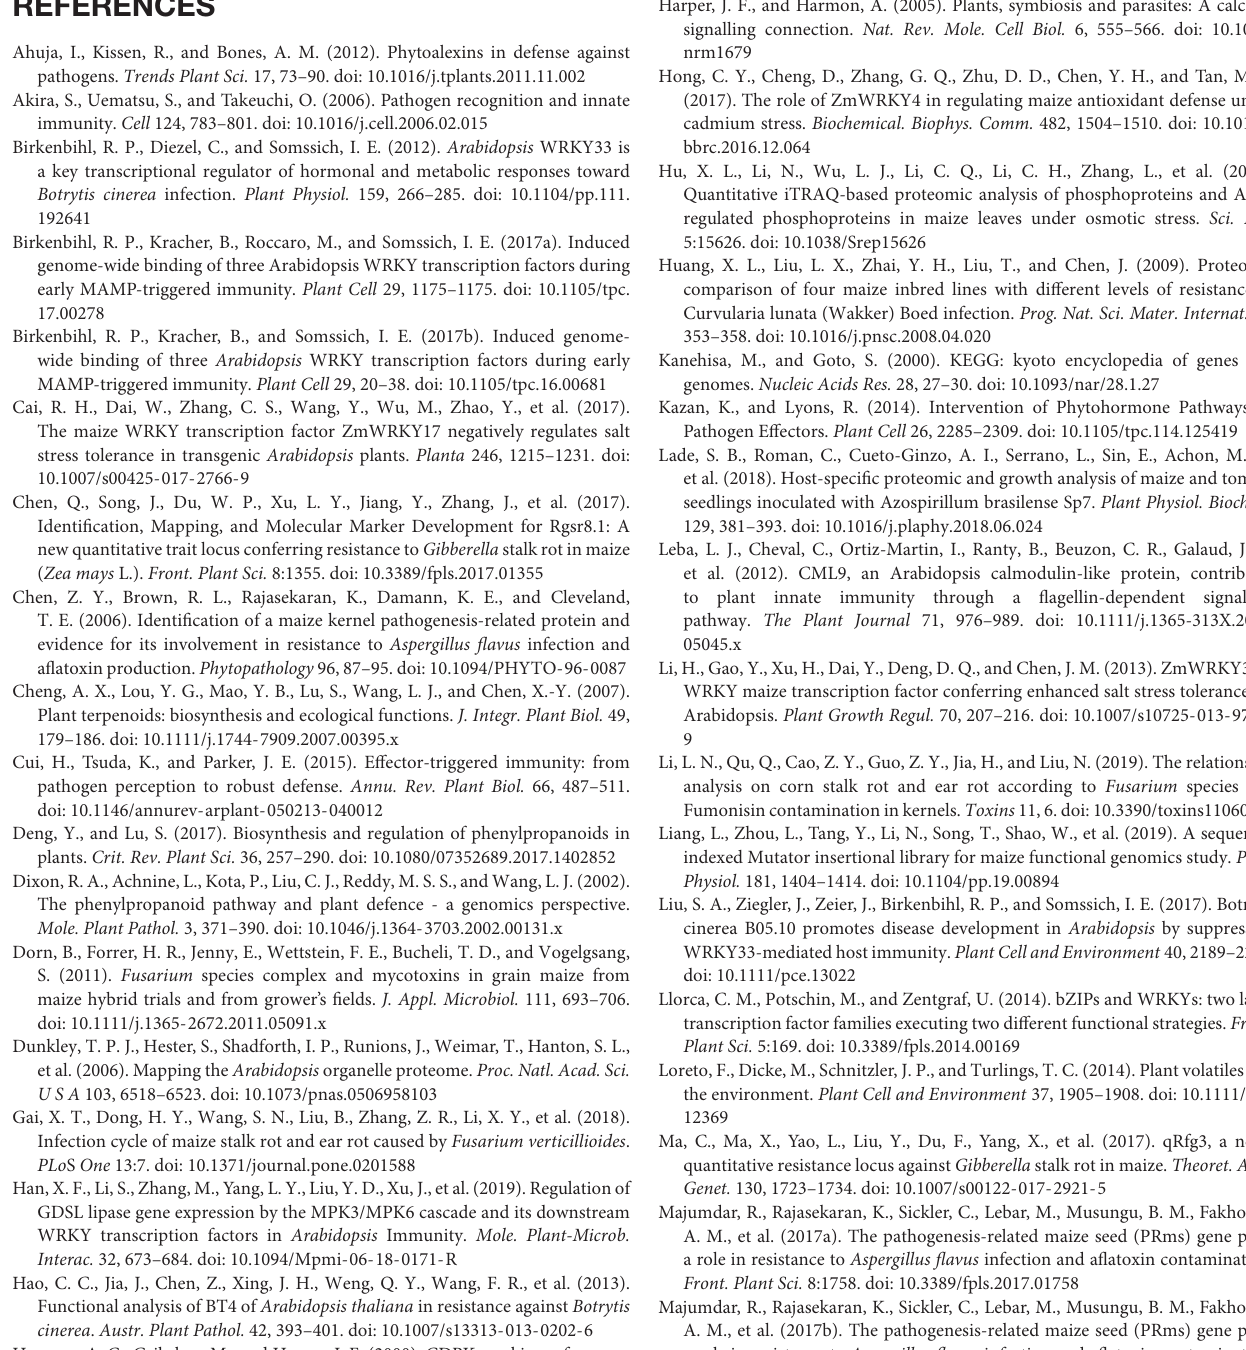
Supplementary Table 1 | MS/MS spectrum database search analysis of proteins identified during F. graminearum infection at 0, 1, and 2 dpi in maize